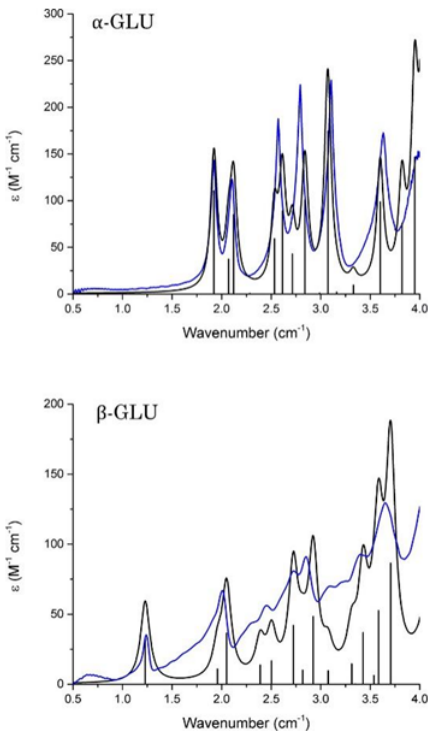
Figure 13. Experimental 100 K THz time-domain spectroscopy (THz-TDS) of α -glutamic acid (GLU) and β -GLU (blue) and solid-state density functional theory simulated spectra (black). The simulated spectra have been convolved using Lorentzian lineshapes with full-width at half-maxima of 96 and 114 GHz for α -GLU and β -GLU, respectively. Reprinted from [163].